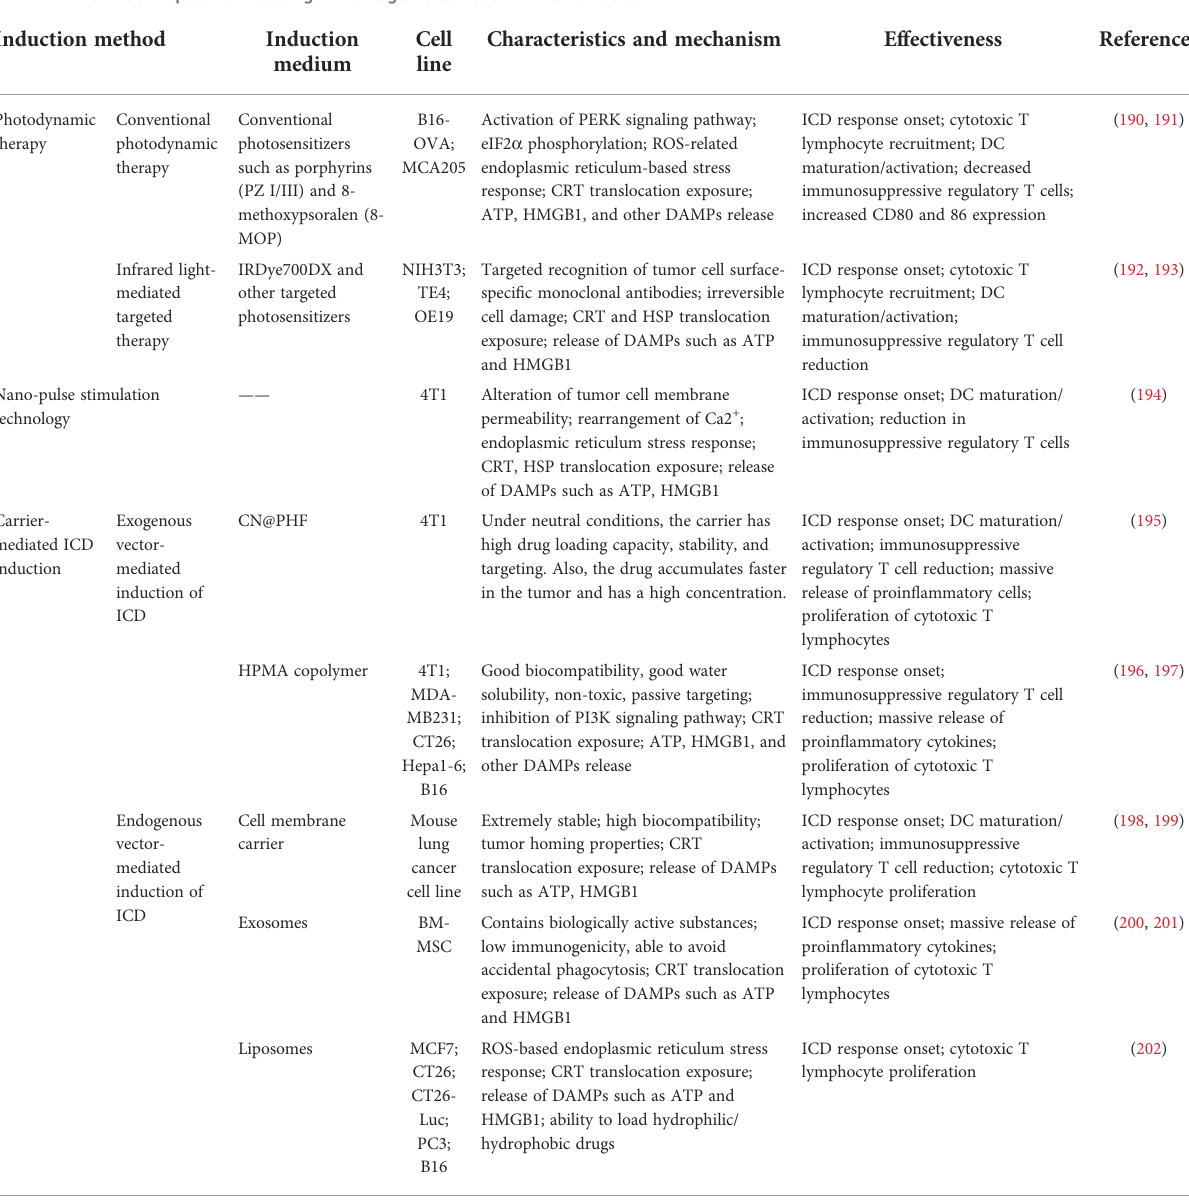
TABLE 4 New techniques for inducing immunogenic cell death in tumor